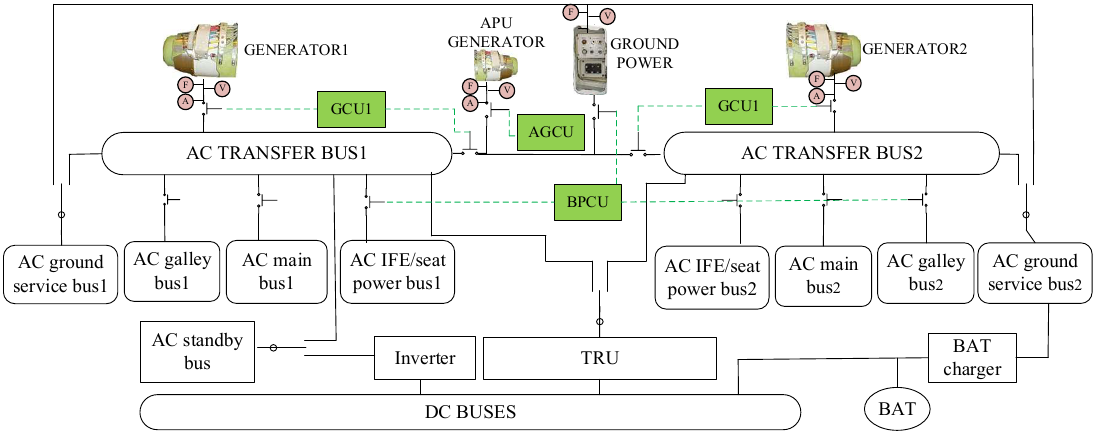
Figure 1. Typical aircraft power grid distribution structure.